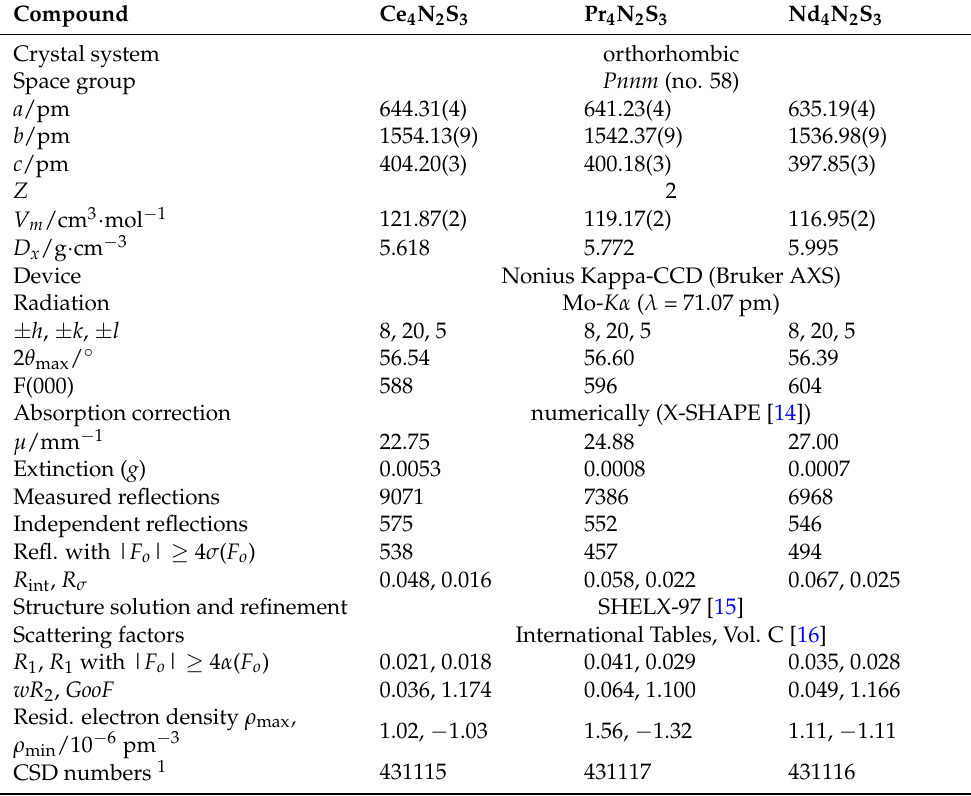
Table 1. Crystallographic data for the three members of the Ln 4 N 2 S 3 series ( Ln = Ce–Nd).